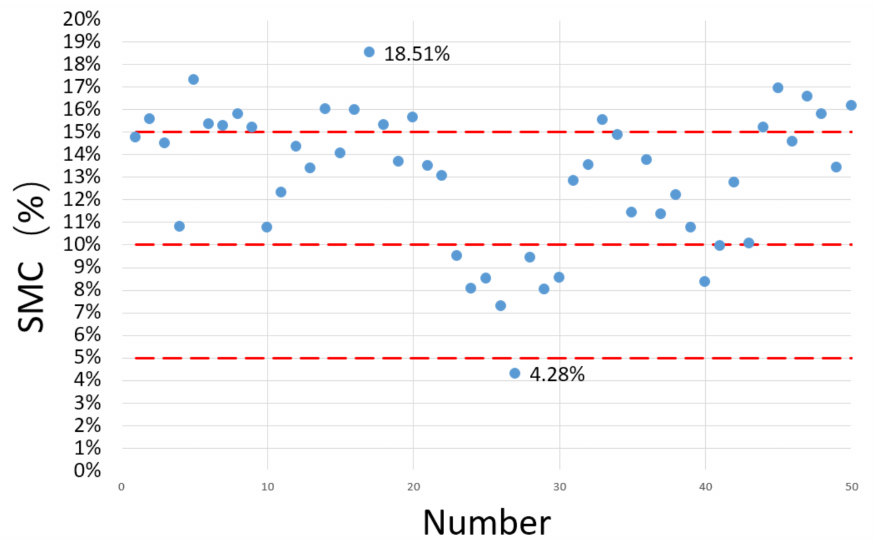
Figure 3. The SMC values of samples of 50 different positions after lab